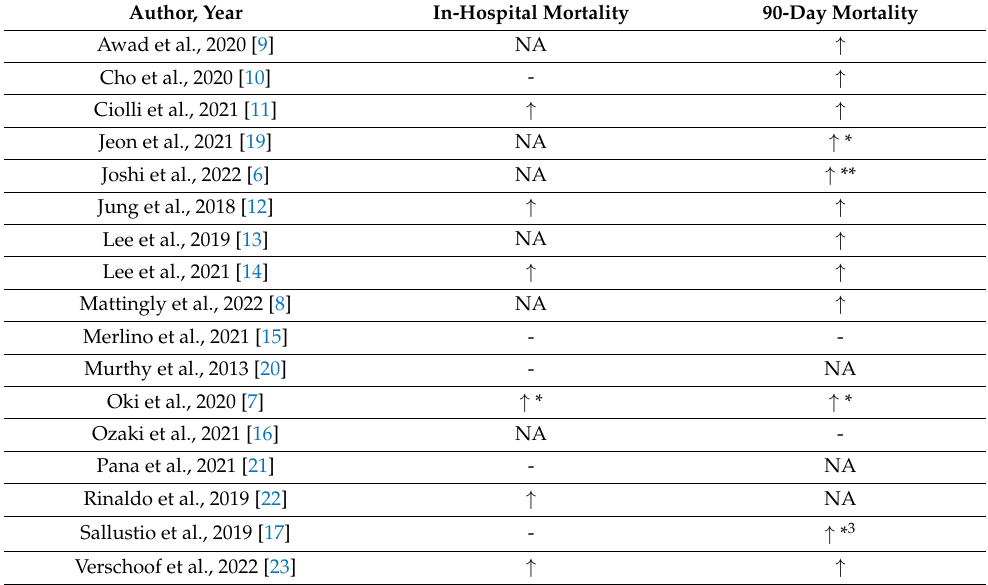
Table 3. Overview of in-hospital and 90-day mortality tendency in cancer patients compared to non-cancer